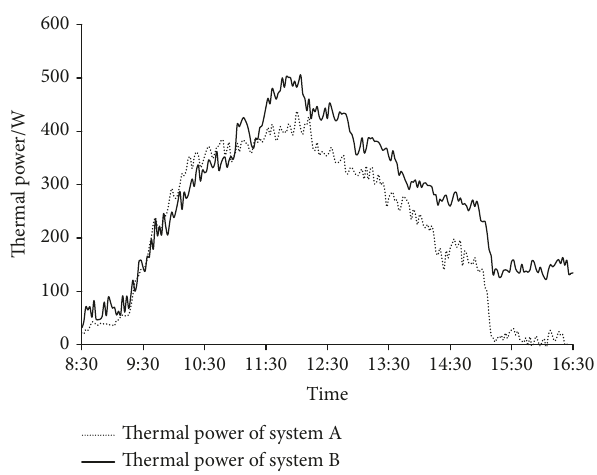
Figure 10: Variation of the thermal power. Figure 11: Variation of electrical power and electrical e ffi